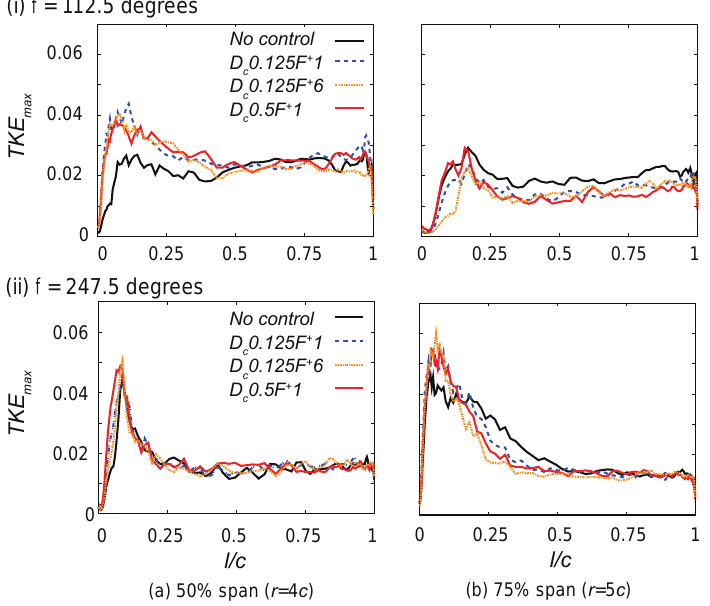
Figure 10. Distribution of the maximum turbulent kinetic energy ( TKE max ) of the suction side of the blade surface at ( a ) 50% and ( b ) 75% of the blade sections from the blade root.